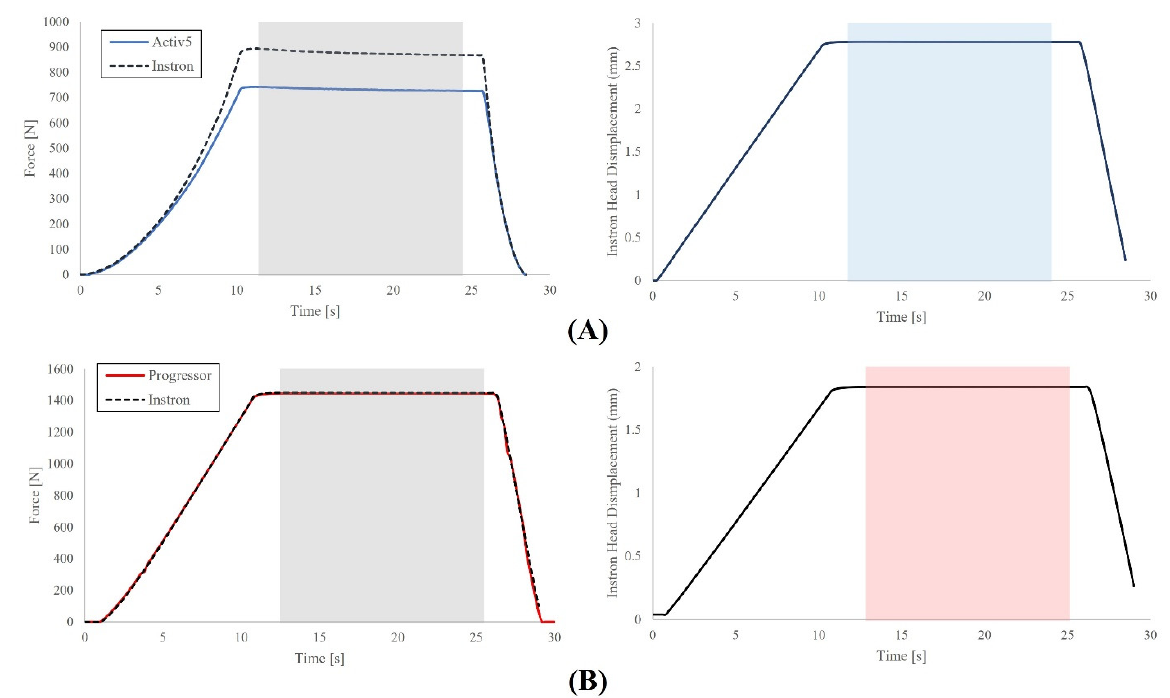
Figure 5. Stress relaxation effects for ( A ) ActivBody Activ5; and ( B ) Tindeq Progressor. Transparent regions denote isolated 14 s hold.